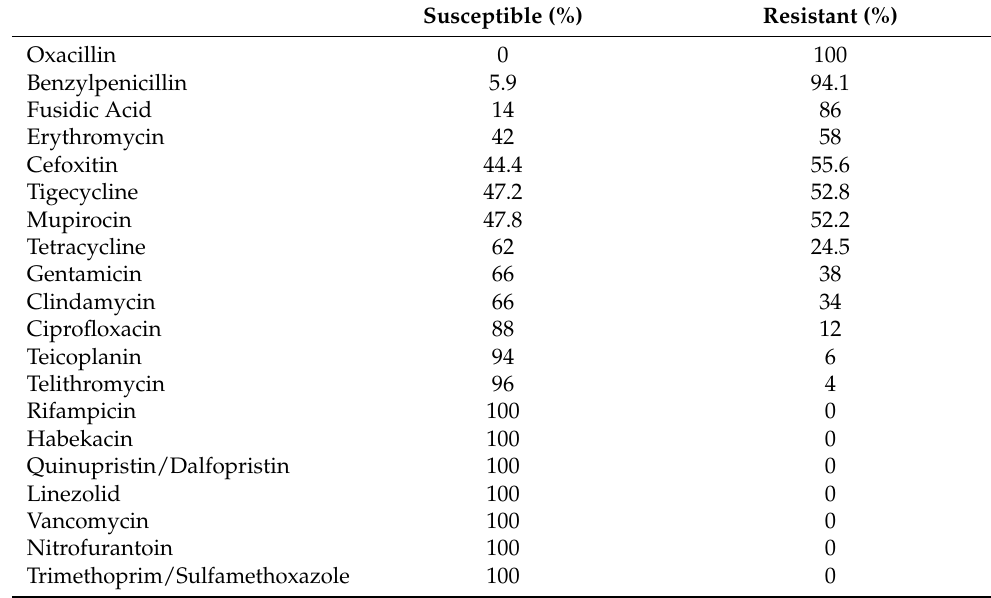
Table 4. Antibiotic susceptibility test on oxacillin-resistant staphylococci ( n =